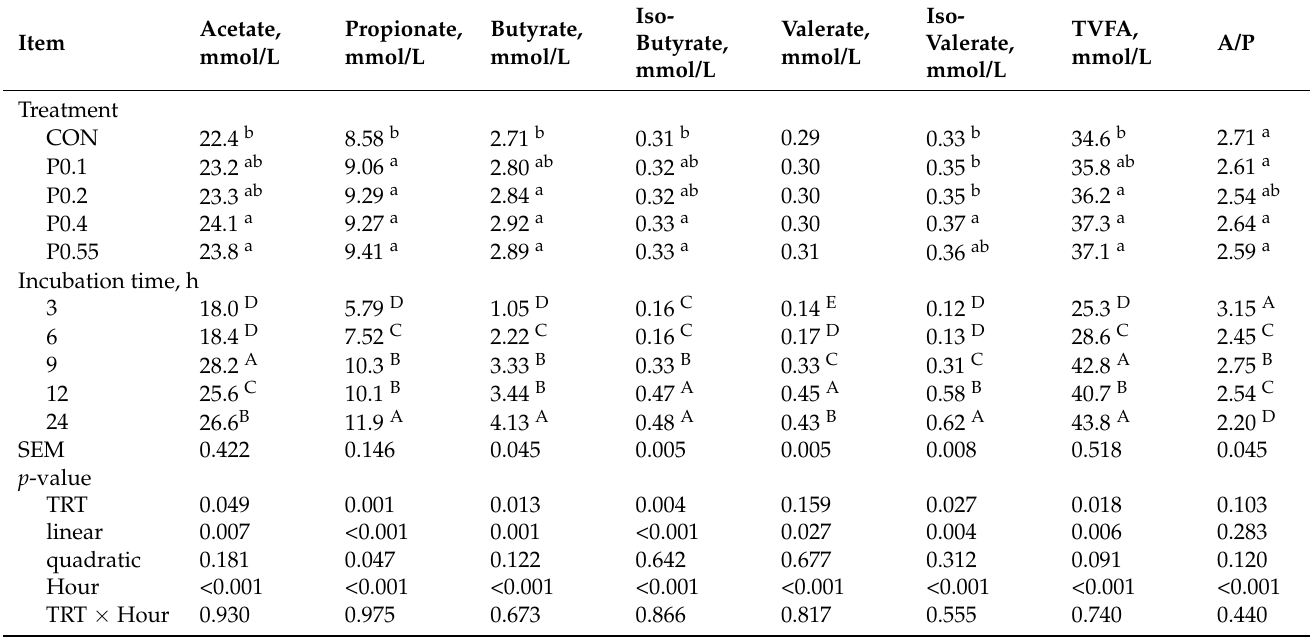
Table 4. The effect of NFP on in vitro ruminal volatile fatty acids within 24 h